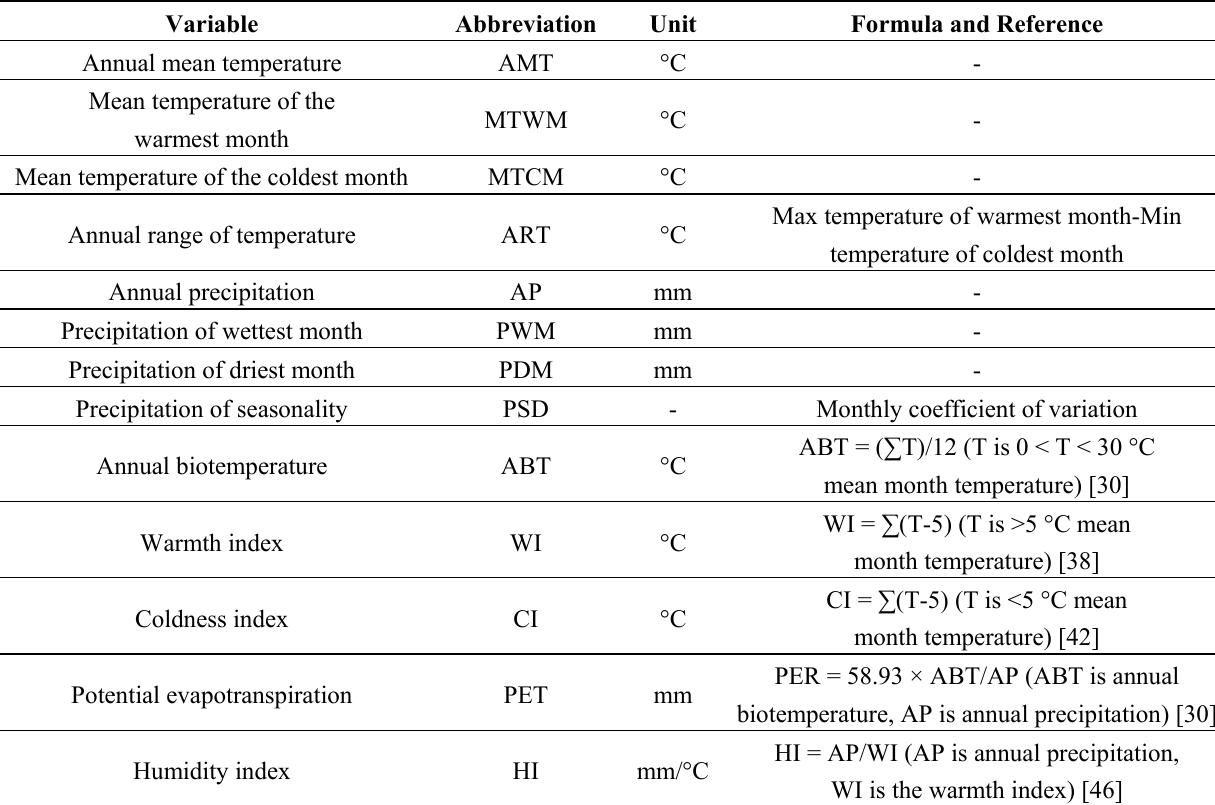
Table 1. Description of 13 climatic factors, corresponding calculated formula and